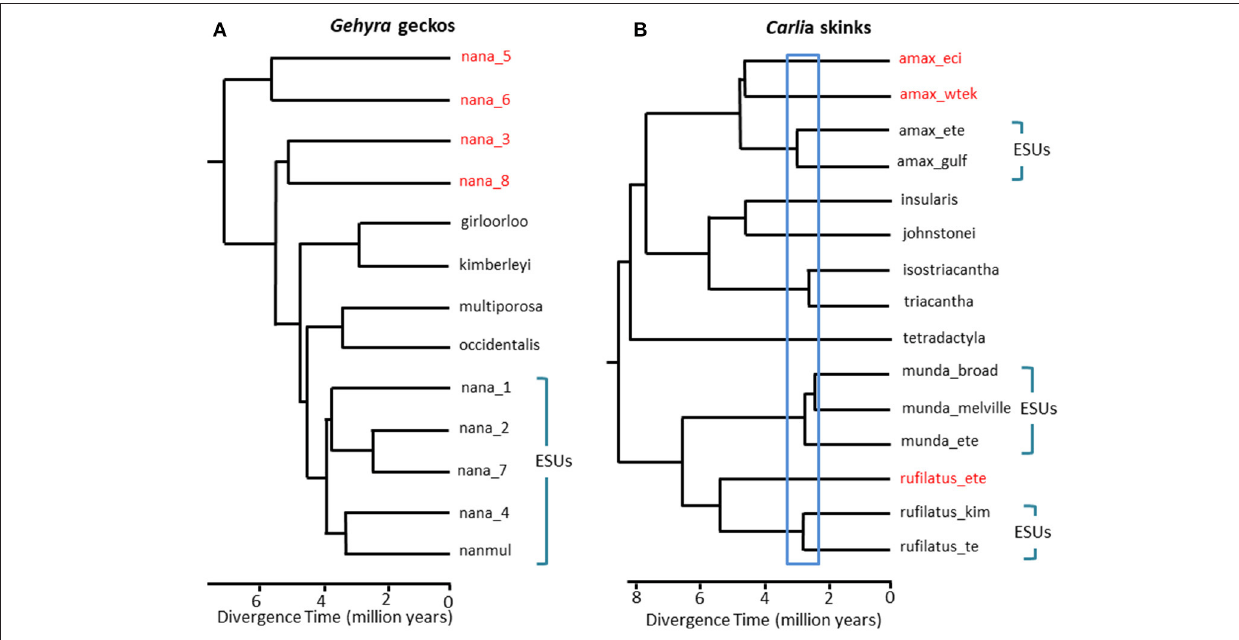
FIGURE 2 | Phylogenomic resolution of species boundaries in lizards from the Australian Monsoonal Tropics (AMT). In each case relationships and relative divergence times are estimated from 100 exons using the multispecies coalescent implemented in StarBEAST2, but the time scales between the two examples are not necessarily the same. (A) Results for the nana group of Gehyra geckos ( Moritz et al., 2018). The phylogenetic diversity of lineages within G. nana, as previously recognized, included four other already described and morphologically distinctive species. Subsequent analyses of range overlaps and morphology has led to recognition of each of the most phylogenetically divergent lineages (red taxon labels) as separate species ( Doughty et al., 2018). The (morphologically inseparable) lineages remaining in G. nana as now recognized can be considered as ESUs. (B) Ongoing resolution of species boundaries in Carlia skinks from the AMT. Some lineages have already been recognized as species based on a combination of genetic species delimitation and post hoc identification of diagnostic morphological differences ( C. insularis and C. isostriacantha ; Afonso Silva et al., 2017b). For other complexes (Potter et al., 2016, 2018), taxonomic revisions are in progress. The blue rectangle indicates the range of divergence times where substantial reproductive isolation, correlated with divergence, has been observed in contact zones between morphologically cryptic lineages of related species ( Singhal and Bi, 2017). Conservatively, and following (Singhal et al., 2018), we recognize as candidate species three genetic lineages with divergences greater than this empirical threshold. This would leave genetically distinct ESUs within each of Carlia amax, Carlia munda, and Carlia rufilatus (blue brackets). The scale bars represent estimates of divergence time in millions of